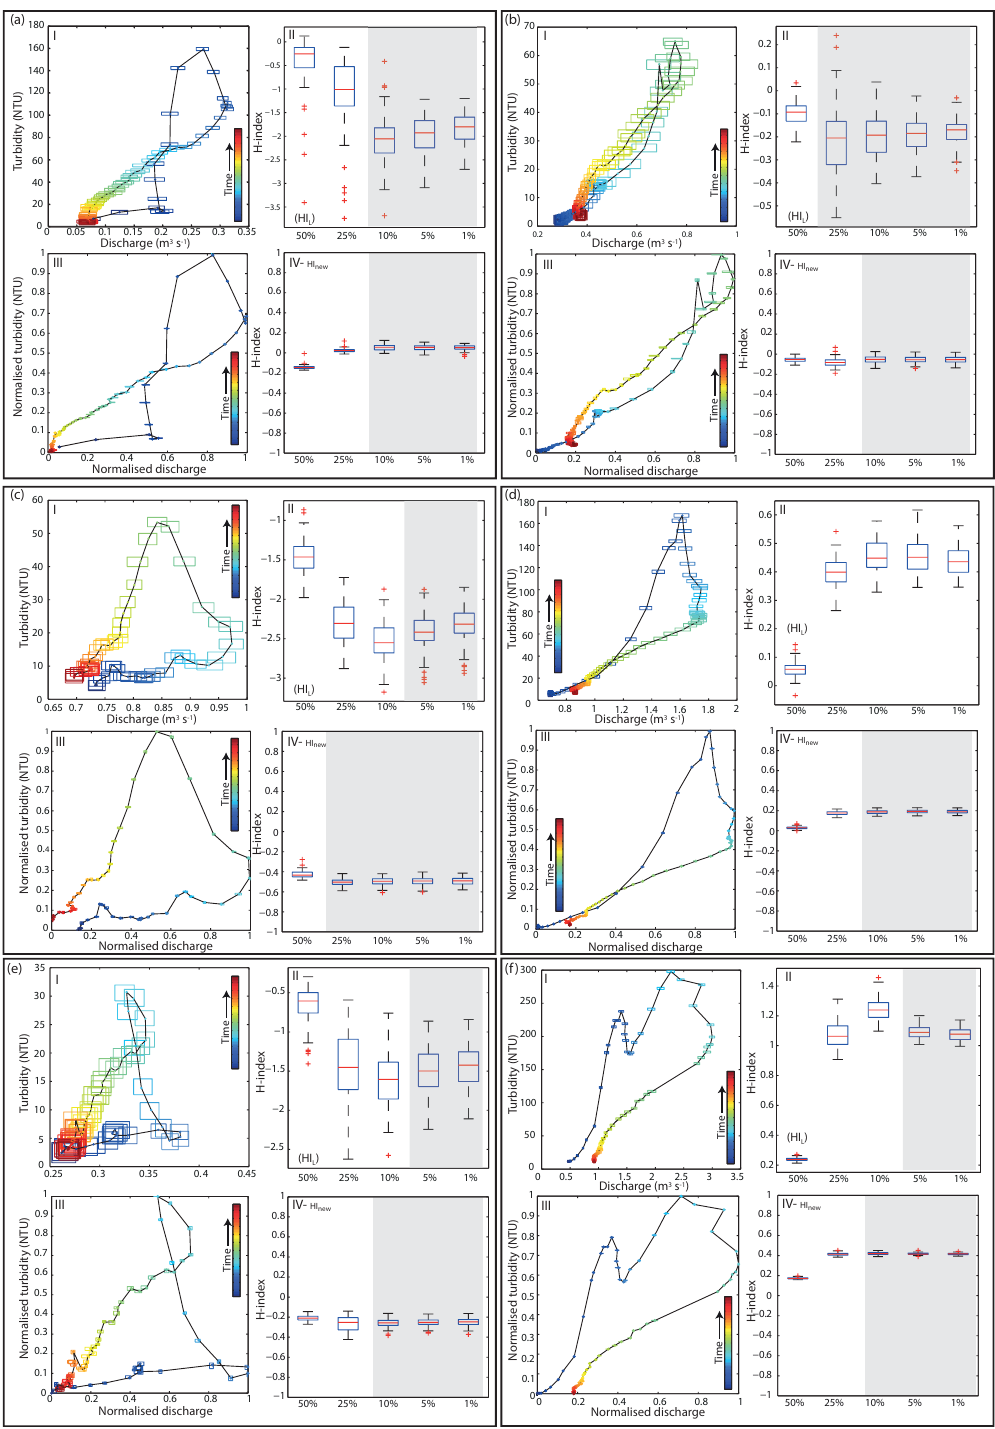
Figure 2. Six storms with varying loop shapes and sizes (a–f) , where (I) is the hysteresis loop using the raw data, (II) is the distribution of HI values using the original and adapted Lawler et al. (2006) methods (HI L / HI LA ) using varying percentiles of flow, (III) is the hysteresis loop plotted using normalised data, and (IV) is the distribution of HI values using the new method (HI new ) using varying percentiles of flow. The grey areas show the distributions which are not statistically different from each other. In panels I and III, the black line represents the median and the boxes represent the 5th–95th percentiles of the uncertainty